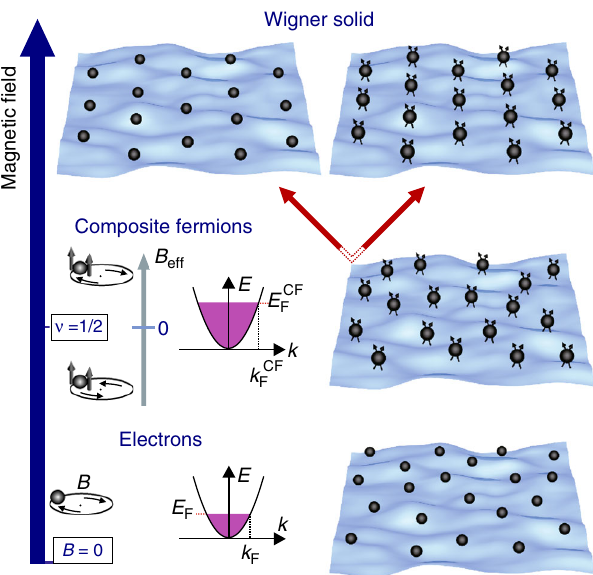
Fig. 1 Schematic of the phases of a 2DES in a magnetic fi eld: The different phases of a two-dimensional electron system (2DES) in a magnetic fi eld. At zero magnetic fi eld (bottom panel) the electrons are described as a weakly interacting Fermi gas with a well-de fi ned Fermi surface. In the half- fi lled lowest LL, e.g., at fi lling factor ν = 1/2, the electrons reduce their mutual interaction by attaching the two magnetic fl ux quanta, resulting in the emergence of new particles, so-called composite fermions (middle panel) 2,3 . These particles form a Fermi surface at ν = 1/2 and move in an effective fi eld B eff = B − B ν = 1/2 giving rise to magnetoresistance oscillations known as the fractional quantum Hall effect (Fig. 2). At even lower fi lling factors, a Wigner solid, a crystalline phase of electrons arranged by the repulsive Coulomb force and another manifestation of many-body correlations, becomes the ground state, which can be formed either by bare electrons (top left) or composite fermions (top